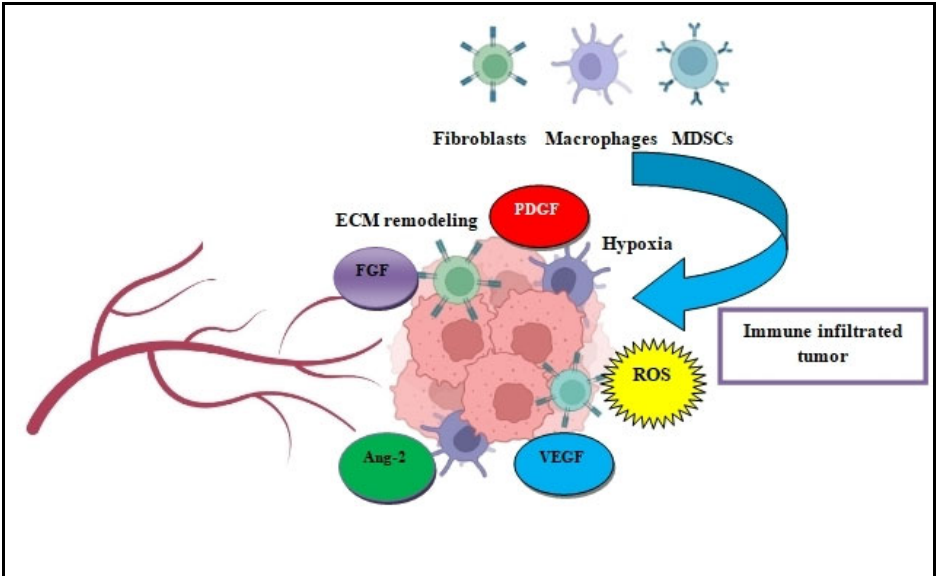
Figure 3. Immune cell infiltration is vital for DTC`s activity. Crosstalk of DTCs with immune cells in the TME prompts ECM remodeling, hypoxia, and immunosuppression. Subsequently, the secretion of angiogenesis-related factors such as Ang-2 FGF, PDGF and VEGF triggers further tumor growth and expansion.